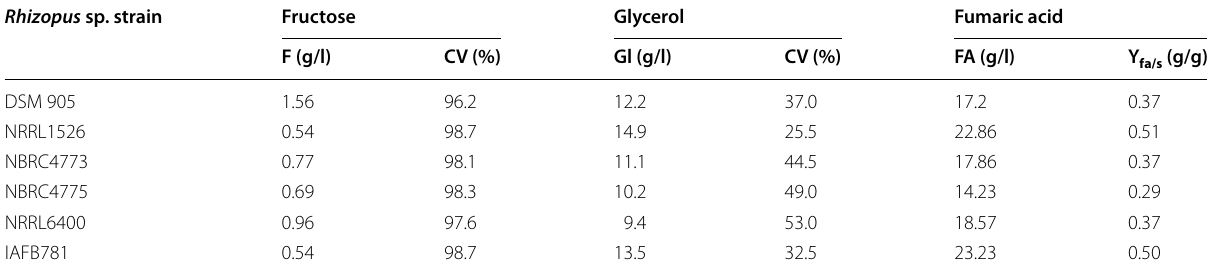
Table 5 Fumaric acid production from glycerol to fructose by various strains of Rhizopus sp. after 168 h of growth (35 °C, 200